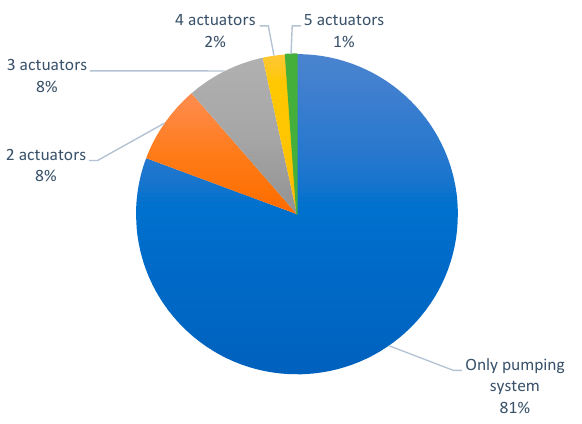
Figure 9. Number of included actuators in papers that propose an irrigation system.